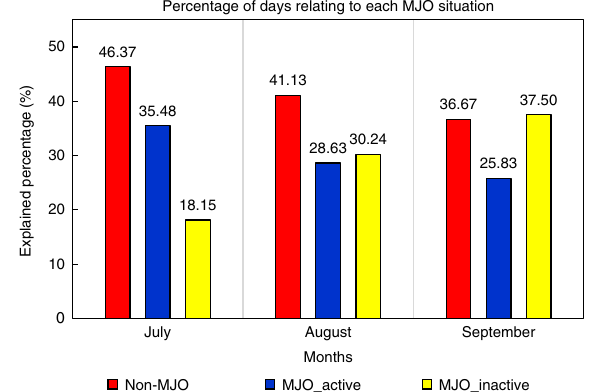
Fig. 6 Occurrence frequency (%) of three Madden – Julian Oscillation (MJO) event types from July to September during eight El Niño developing years in the period 1979 – 2016. Red bars represent the occurrence frequency (%) of non-MJO, blue for active MJO, and yellow for inactive MJO. An El Niño developing year is de fi ned when the above-moderate El Niño events (including moderate events) develops from weak